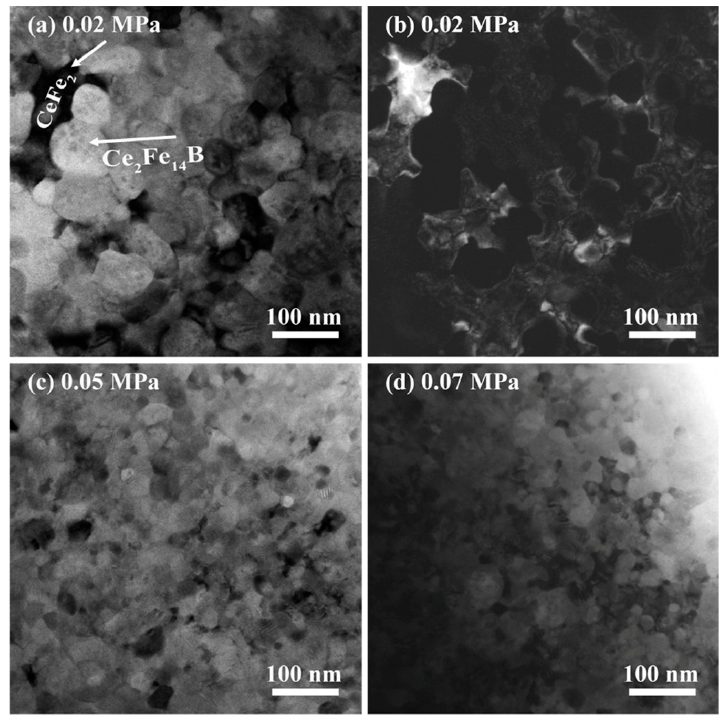
Figure 3. Transmission electron microscopy (TEM) images of Ce 17 Fe 78 B 6 ribbons prepared at various chamber pressures at the wheel speed of 15 m·s − 1 : ( a ) bright field (BF) and ( b ) dark field (DF) images of samples made with pressure of 0.02 MPa; ( c ) 0.05 MPa; ( d ) 0.07 MPa. The arrows mark the formed phases. DF image in ( b ) shows CeFe 2 phase.